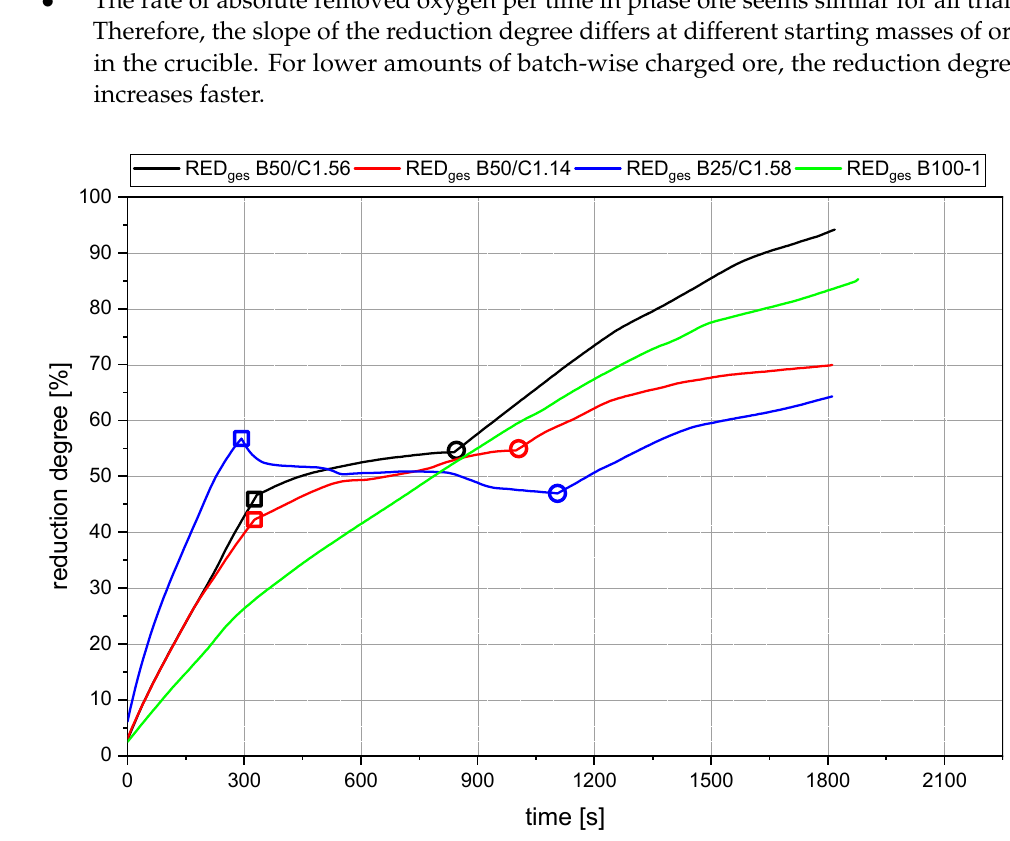
Figure 17. Comparison of reduction degrees of B50/C1.56, B25C1.58, B50/C1.14 and B100-1. Square: Start of Charging, Circle: End of Charging.